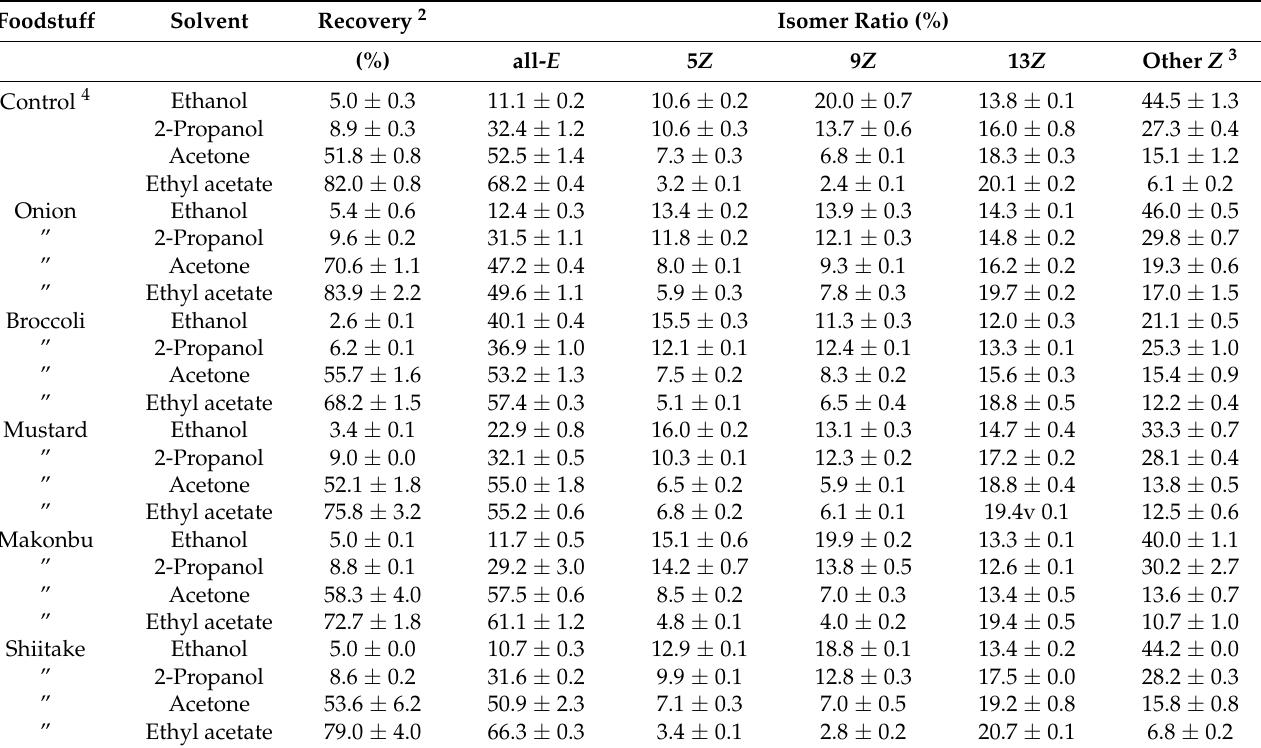
Table 2. Effects of extraction solvents and foodstuffs on lycopene recovery and each lycopene isomer ratio in the extract. 1.